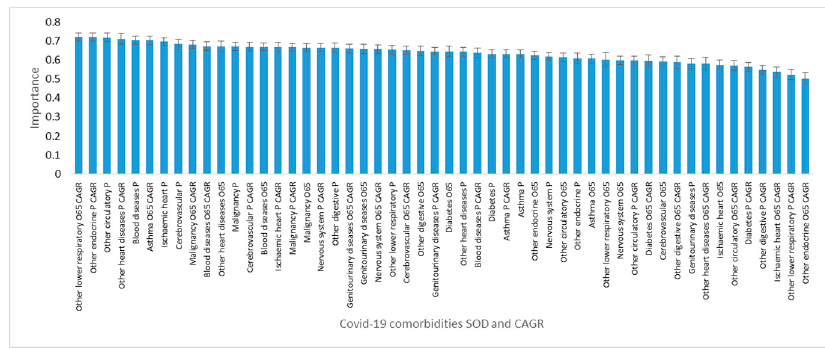
( C ) Variable importance in COVID-19 comorbidities’ amalgamation. Figure 3. Results of tree clustering of COVID-19 comorbidities for 28 European Union countries: heat maps, cluster attributes, and variable importance. Tree clustering results are based on Euclidian distances and the Ward’s amalgamation method applied on shares of death (SOD) and compound annual growth rates (CAGR) for all 28 EU countries, on mean values between 2011 and 2016. Panel A depicts on the left the heat map of EU countries in terms of SOD and CAGR—greener cells indicate lower standardized values, and darker red cells indicate higher standardized values—for each of the 13 COVID-19 comorbidities. Areas of the heat map coloured in green indicate lower vulnerability, and areas coloured in red indicate higher vulnerability to diseases, measured in SOD and / or CAGR. The right side of the panel shows the dendrogram of countries’ distributions in clusters based on the linkage distance (the distance between clusters’ members). Panel B presents the standardized (or normalized means, i.e., means on adjusted values to scale) of clustering variables (SOD and CAGR for the 13 COVID-19 comorbidities) for the two statistically significant clusters and the error bars based on standard error. Cluster 1 has 13 members, and cluster 2 has 15 members. Panel C presents the variables’ importance for predicting cluster membership via the C&RT / boosted tree algorithm, based on 100 repeatedly drawn samples via bootstrapping. The closer to 1 the variable is, the higher its importance for countries’ inclusion in one of the two clusters. Error bars in panel C are based on standard deviations of variable importance. There are two clusters of EU countries based on their populations’ vulnerability to COVID-19 comorbidities: cluster 1 includes 13 western EU countries, and cluster 2 includes 11 eastern countries and 4 western countries (Sweden, Malta, Finland, and Greece). Countries in cluster 1 have higher SOD of all diseases than cluster 2, except for ischemic heart, cerebrovascular diseases, and other circulatory diseases, but lower growth rates of diseases SOD, except for blood diseases, other heart diseases, and other lower respiratory diseases, for both population sets. Overall, SODs were more important than their CAGR for countries’ assignments to clusters, but the highest power of differentiation between western and eastern EU countries belongs to diseases with high CAGRs among the elderly population.